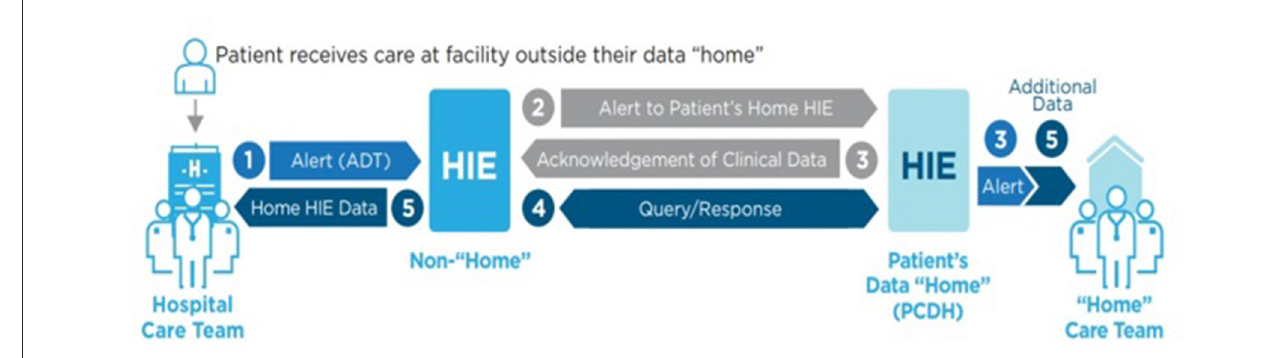
FIGURE 2 | Patient-centered data home process (18).